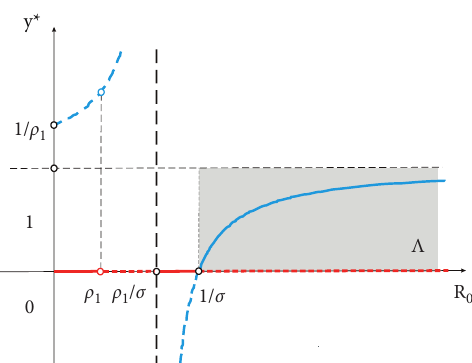
Figure 3: Bifurcation diagram of system (9). Locally asymptotically stable and unstable points have been indicated, respectively, with continuous and discontinuous lines. The region of biological sense Λ is indicated with gray